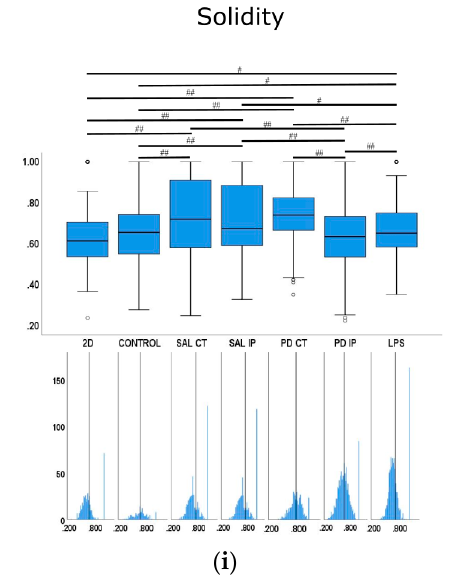
Figure 10. Quantitative morphometric analysis of microglia growing in repopulated striatal decellularized matrices. Nine shape descriptors are quantified for microglia growing in the decellularized matrices from the control animals (CONTROL), matrices from the contralateral and ipsilateral hemispheres of saline and 6-OHDA-lesioned mice (SAL CT, SAL IP, PD CT, and PD IP, respectively), and 2D surface (with and without LPS stimulation). Area ( a ), perimeter ( b ), major axis ( c ), minor axis ( d ), circularity ( e ), Feret’s diameter ( f ), aspect ratio ( g ), roundness ( h ), and solidity ( i ). The values for the corresponding feature are shown as a box displaying the maximum, minimum, and mean ± SEM values. Welch’s ANOVA followed by Games Howell post hoc test were performed (# p < 0.05 and ## p < 0.001). Outliers are marked with the symbols ° and *. The sampling distribution was tested for normality using the Shapiro − Wilk test and for homogeneity of variances using the Levene’s test. Frequency distribution plots for individual cells are shown below each boxplot, with the vertical line indicating the respective population mean.